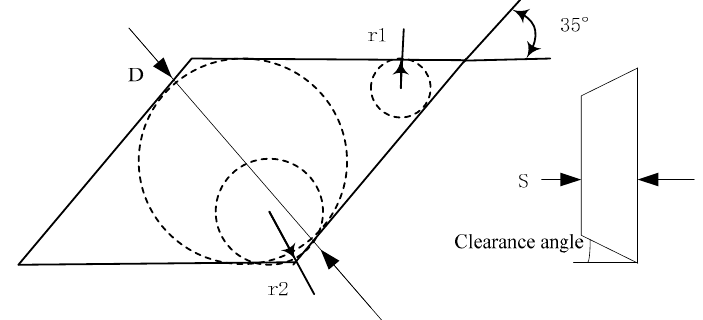
Figure 8. Geometry diagram of the indexable insert.